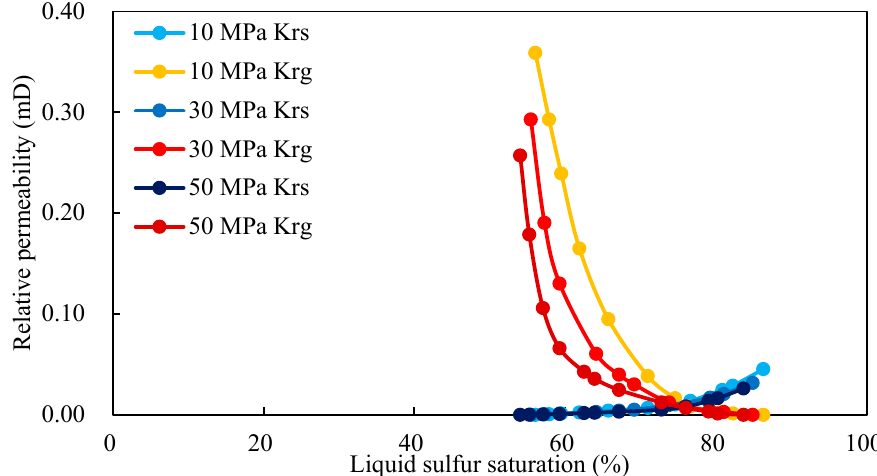
Figure 9. Gas–liquid sulfur relative permeability curves of Core 3 at different confining pressures.